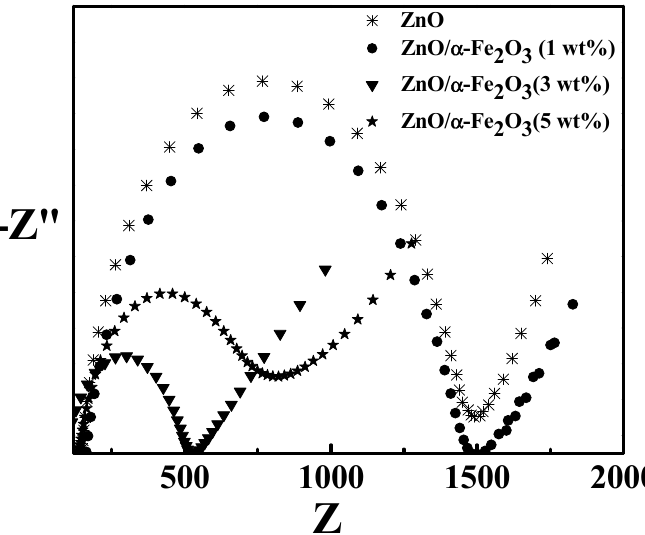
Figure 6. Electrochemical impedance spectroscopy (EIS) spectra of ZnO; ZnO / α -Fe 2 O 3 (1 wt%); ZnO / α -Fe 2 O 3 (3 wt%); and ZnO / α -Fe 2 O 3 (5 wt%).